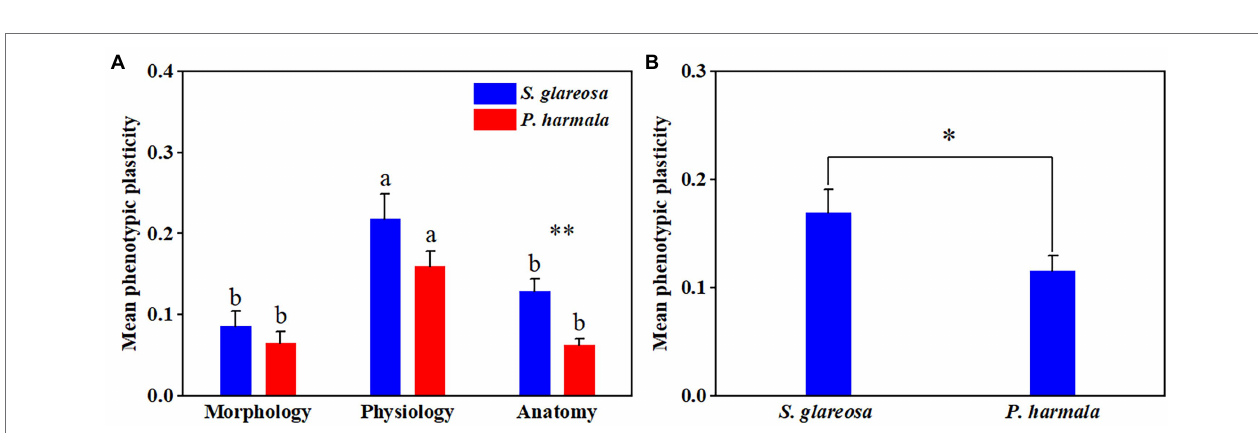
FIGURE 6 | Mean phenotypic plasticity of S. glareosa and P. harmala . (A) Mean phenotypic plasticity of all treatments of S. glareosa and P. harmala divided by trait types. (B) Total mean phenotypic plasticity of S. glareosa and P. harmala . Different lower-case letters represent significant differences within each traits types for each species ( p < 0.05). Asterisk represents significant differences between S. glareosa and P. harmala (* p < 0.05 and ** p <